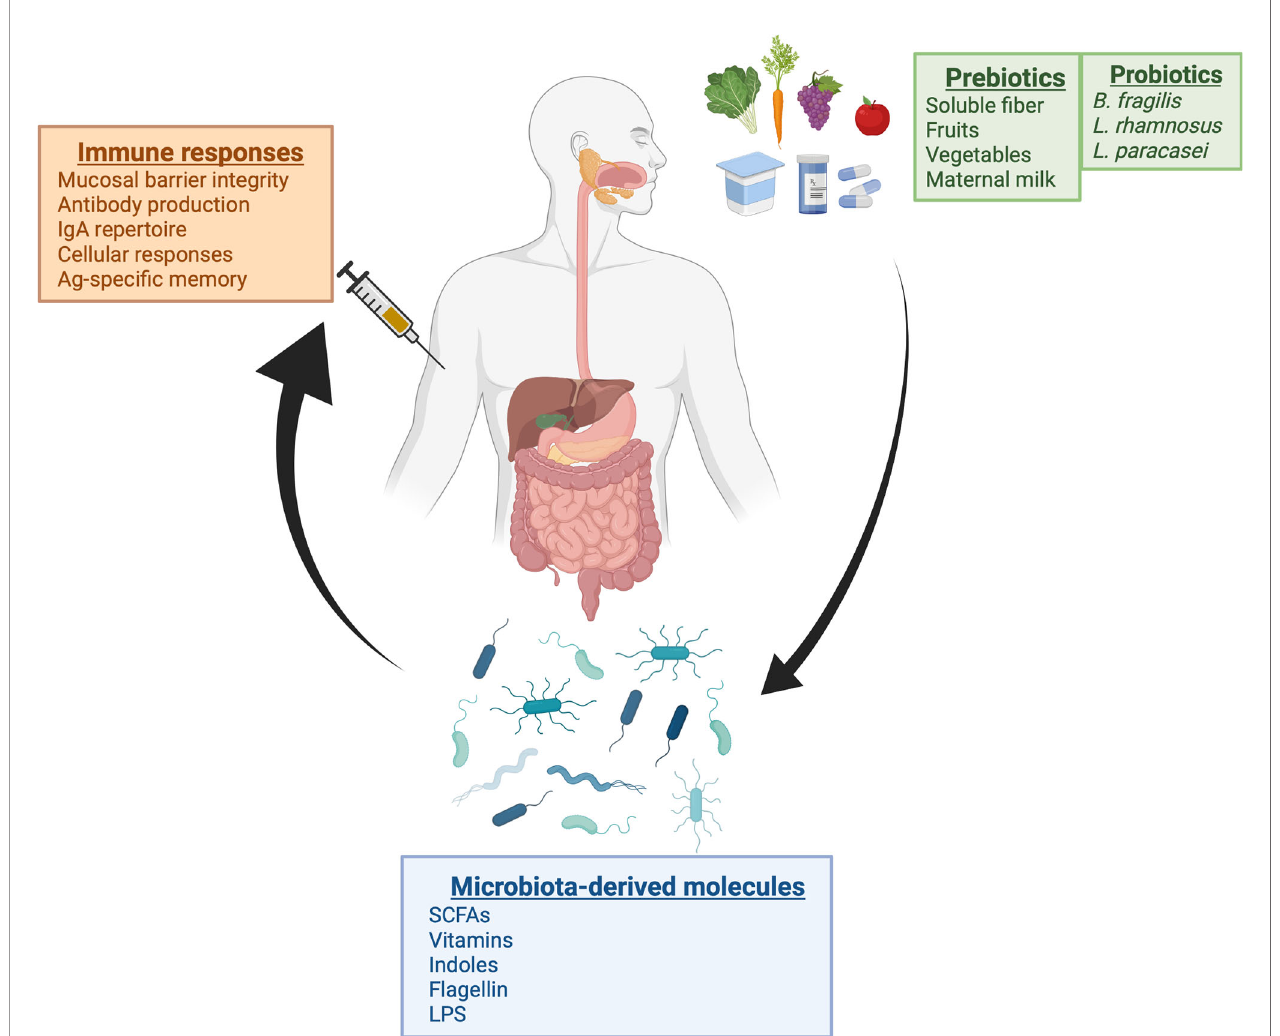
FIGURE 1 | Schematic view of the microbiome-immunity relationship in the context of vaccination. Recent studies demonstrate that there is an association between microbiota and vaccine responses. Gut microbiome composition can be modulated through dietary intake and other environmental factors such as the use of antibiotics or probiotic consumption. With the discovery that abundance of speci fi c bacterial taxa is correlated with increased immune responses after vaccination, therapeutic strategies using pre- or probiotics in combination with vaccination could represent an effective alternative to increase vaccine responses. Created with